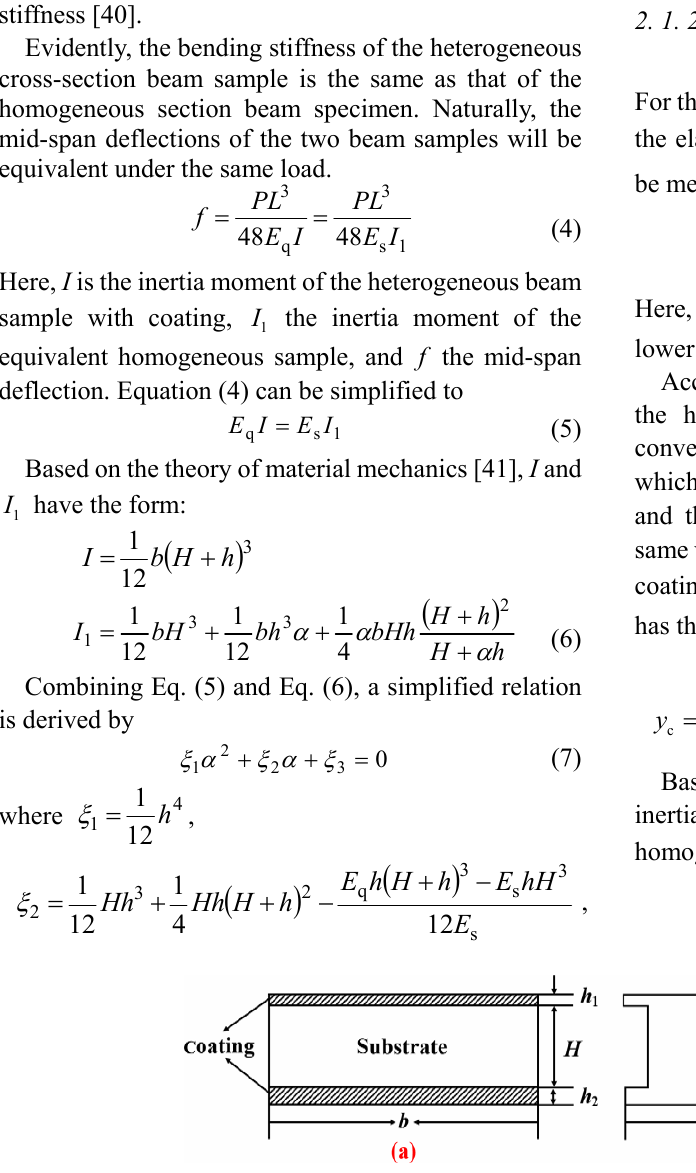
Schematics of the equivalent cross-section transformations of a double-face coated sample: (a) heterogeneous cross-section, (b) homogeneous